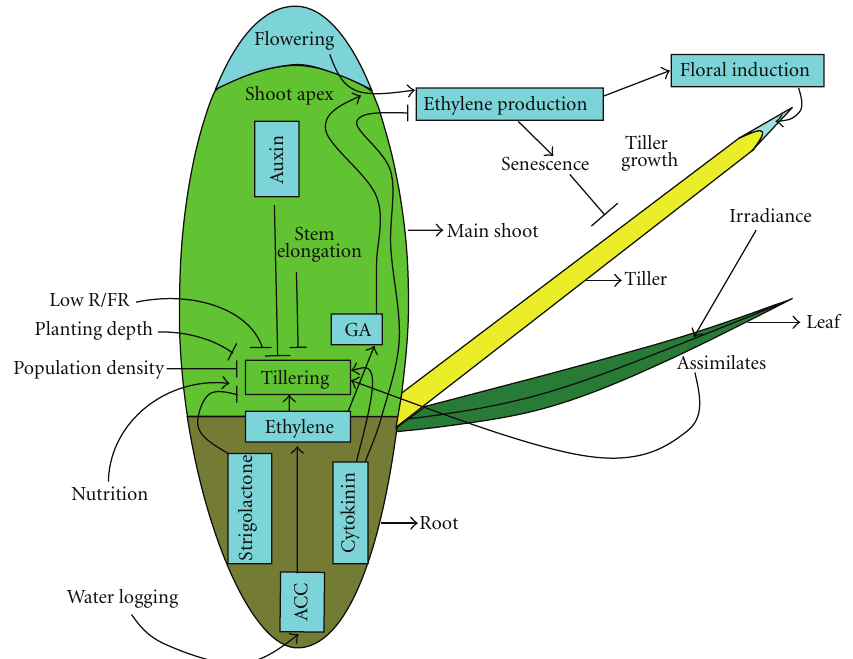
Figure 2: Schematic of factors influencing tiller production and development in Oryza species. Arrowhead lines indicate promotion and flat-ended lines indicate